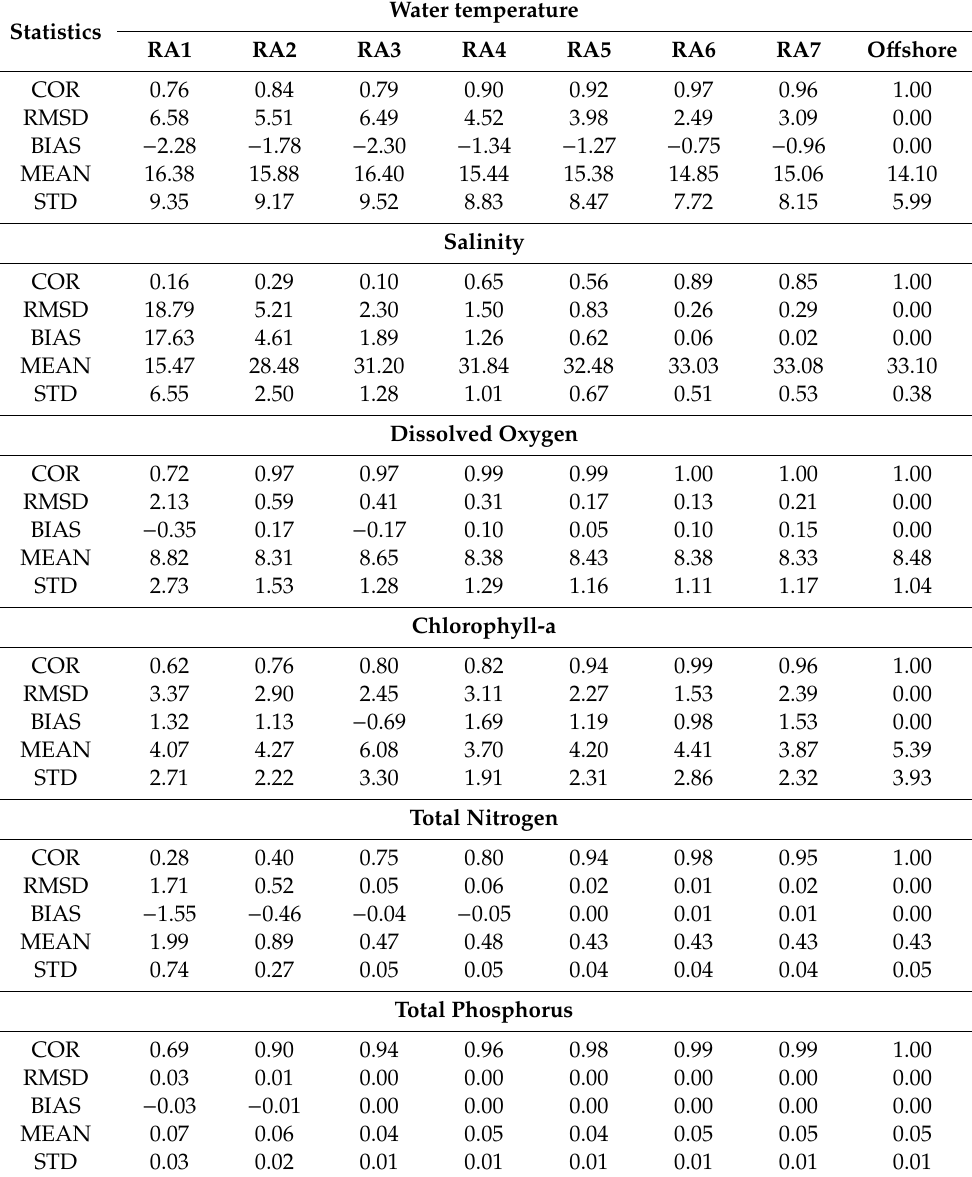
Table 5. Statistical quantities of the time-series distribution for six variables at each optimal point with the o ff shore as a reference